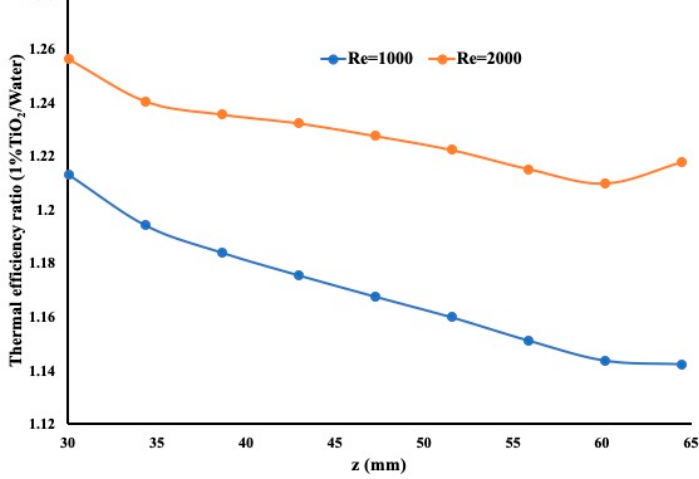
Figure 10. Thermal efficiency ratio between nanofluid and water (no insert).